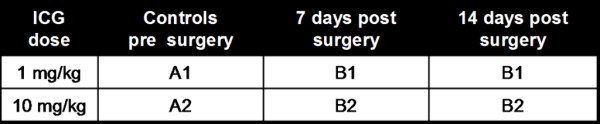
Overview of the different animal groups: the control group (A) and the experimental group (B), further divided into two dose groups, that received intravenous injections of 1 mg/kg (A1, B1) and 10 mg/kg (A2, B2) ICG.